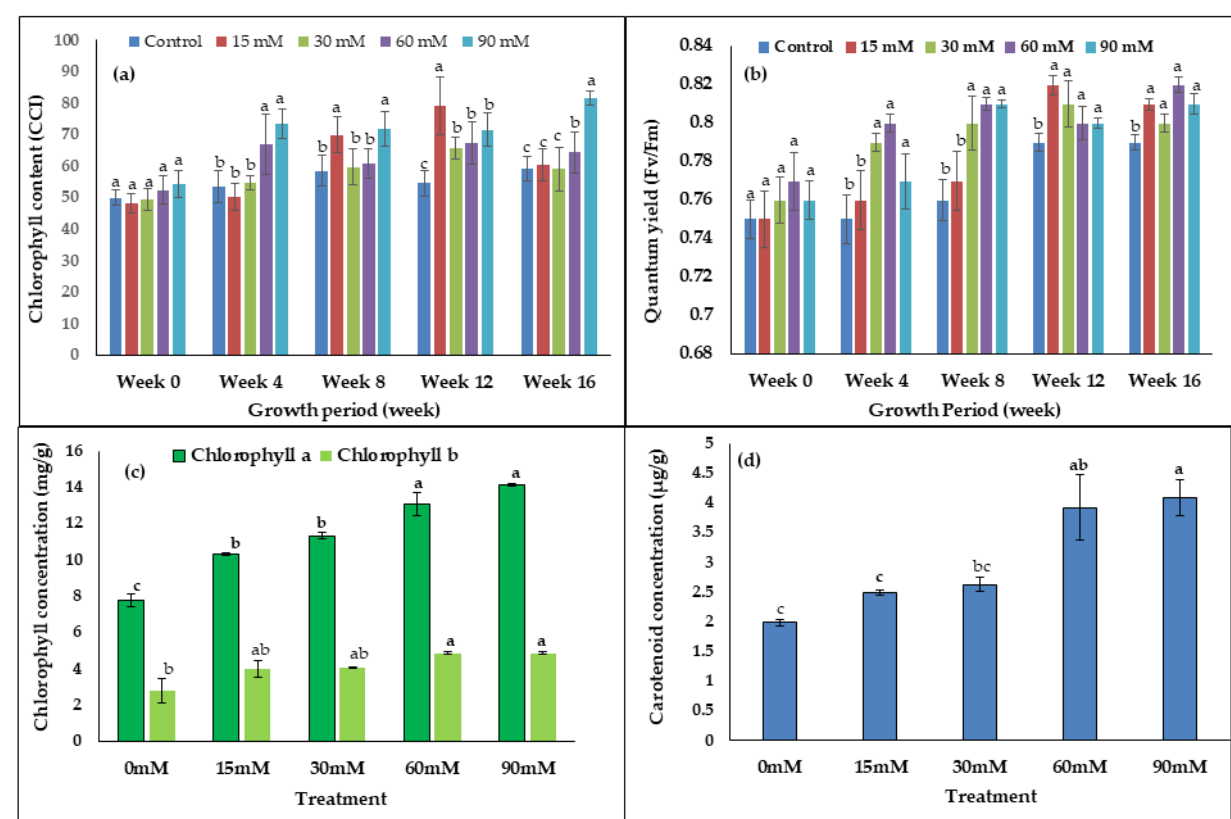
Figure 3. The effects of H 2 O 2 on ( a ) chlorophyll content, ( b ) chlorophyll florescence, ( c ) concentration of chlorophyll a and chlorophyll ( b ) and ( d ) total carotenoid content. Bars represent means ( n = 7) ± standard error (S.E.). a, b, and c indicate significant differences within each growth period ( p < 0.05, Tukey’s HSD-test).